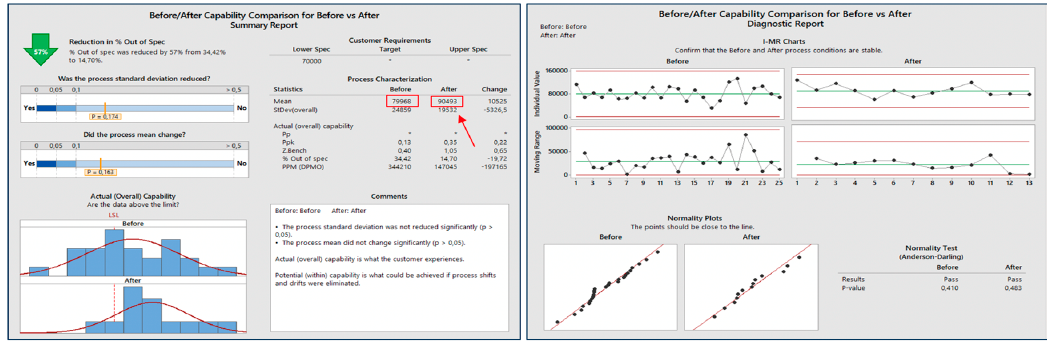
Figure 11. Weekly output improvement.